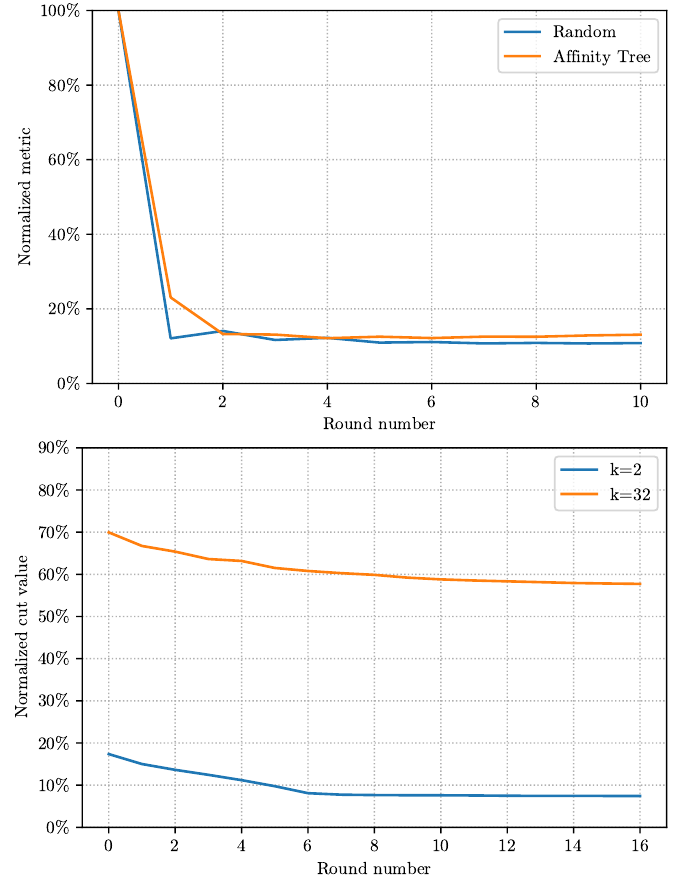
Figure 8. Convergence rate of Aff+Metric ( top ) and Aff+Swap ( bottom ) on Twitter